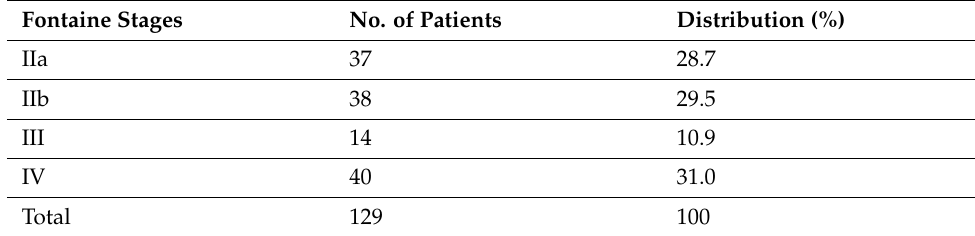
Table 2. Fontaine stages in the study population (n = 129).